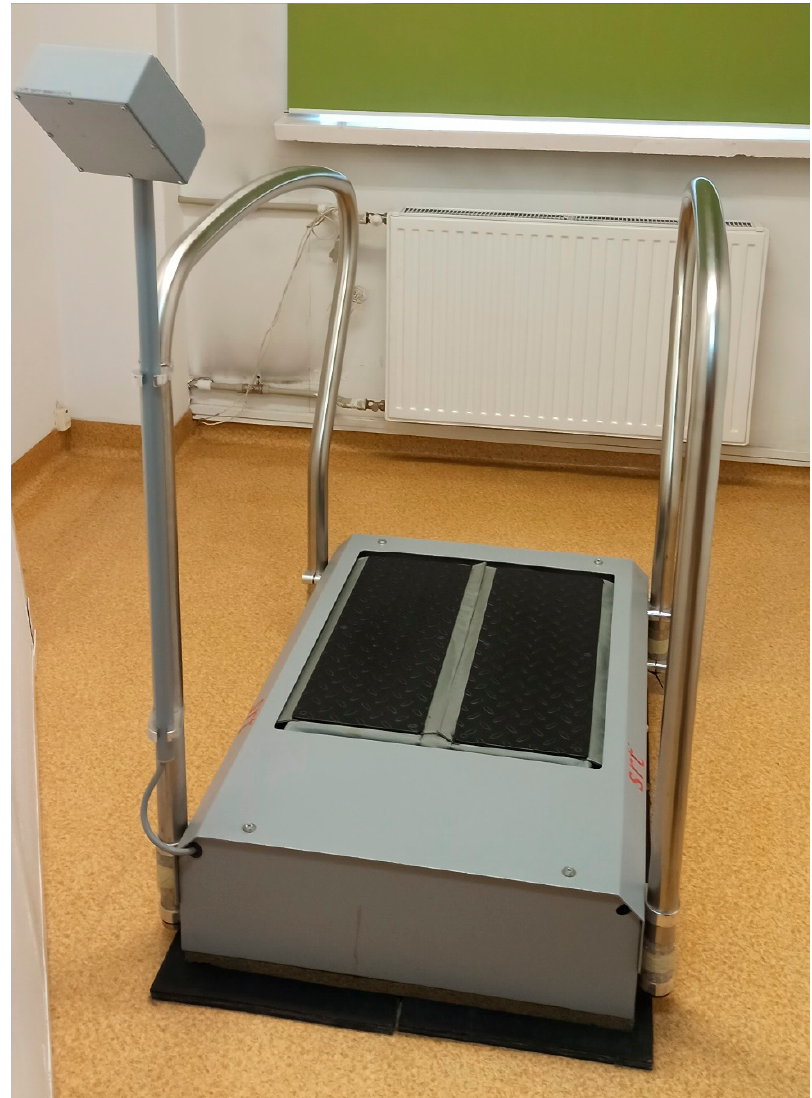
Figure 1. The SRT Zeptor ® Medical-plus noise device.